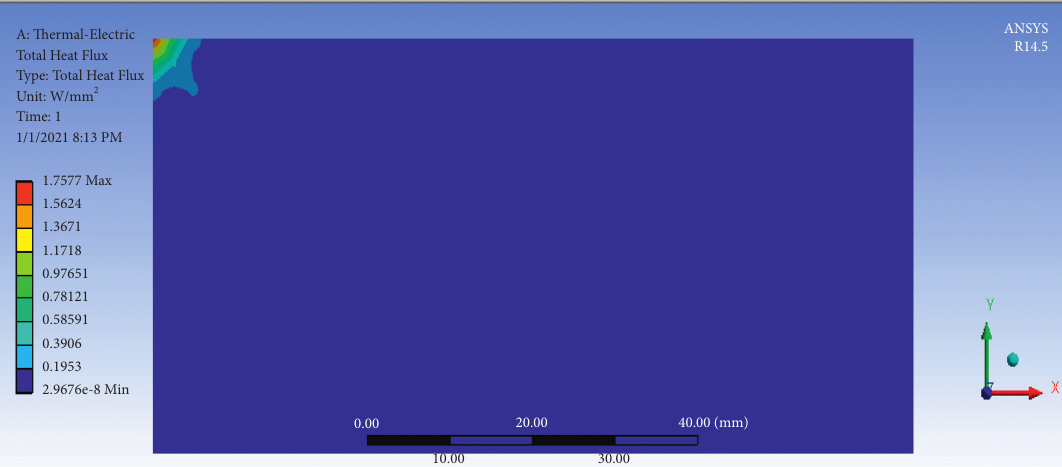
ANSYS R14.5A: Thermal-Electric